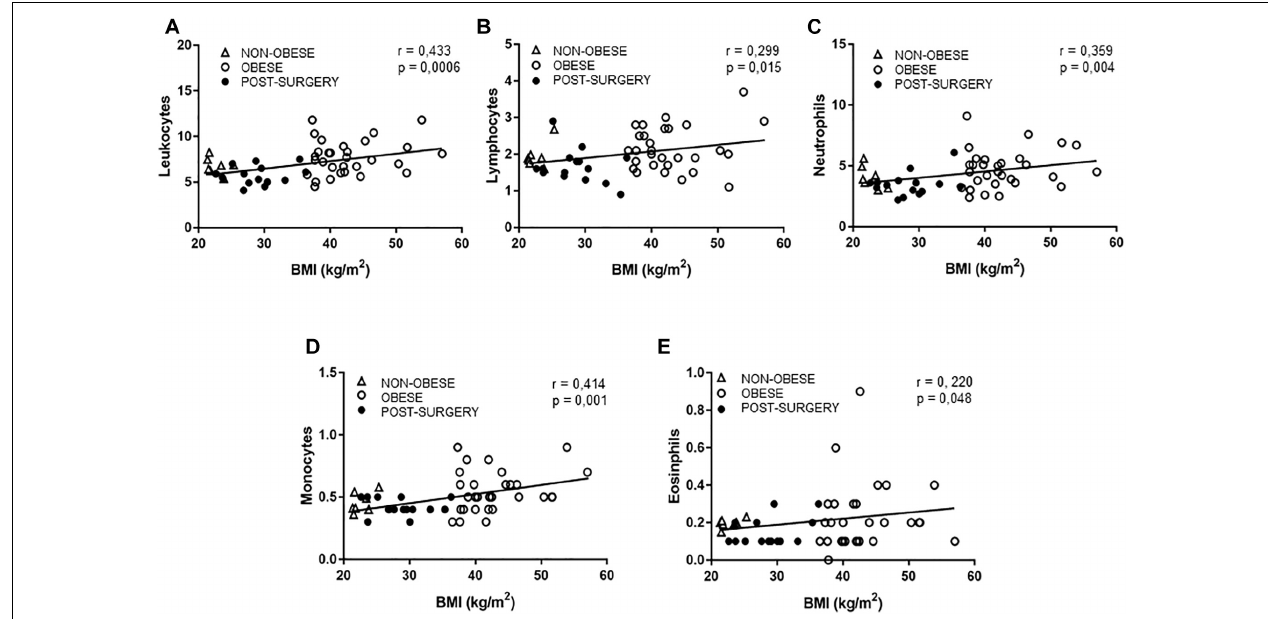
FIGURE 3 | (A–E) Correlations between BMI and total leukocytes (A) , lymphocytes (B) , neutrophils (C) , monocytes (D), and eosinophils (E) . White triangles correspond to non-obese, white circles correspond to obese and black circles correspond to Post-surgery.